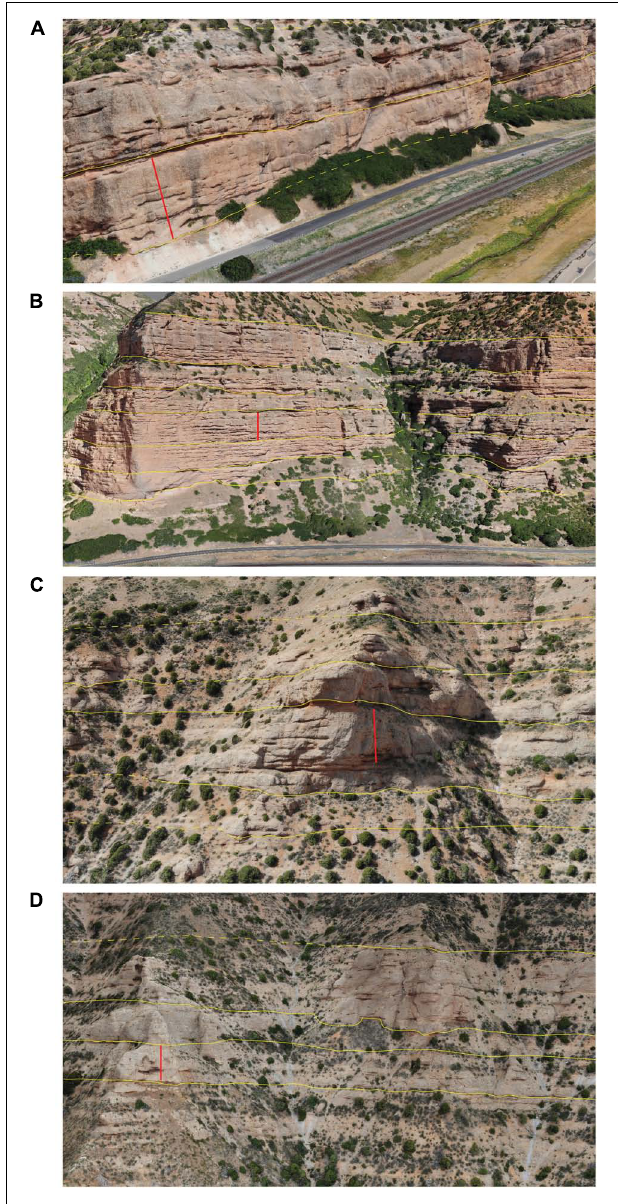
FIGURE 10 | Interpreted selections from digital outcrop models. Fifth-order bounding surfaces are marked by yellow lines (dashed where uncertain or covered). These bounding surfaces can generally be recognized by their lateral continuity and the frequent presence of a paleosol cap on the underlying lithosome (though this is often removed by scouring from the overlying lithosome). Red lines on each images are approximately 25 m long. (A) and (B) are from the Echo Canyon model. (C) and (D) are from the Richards Mountain